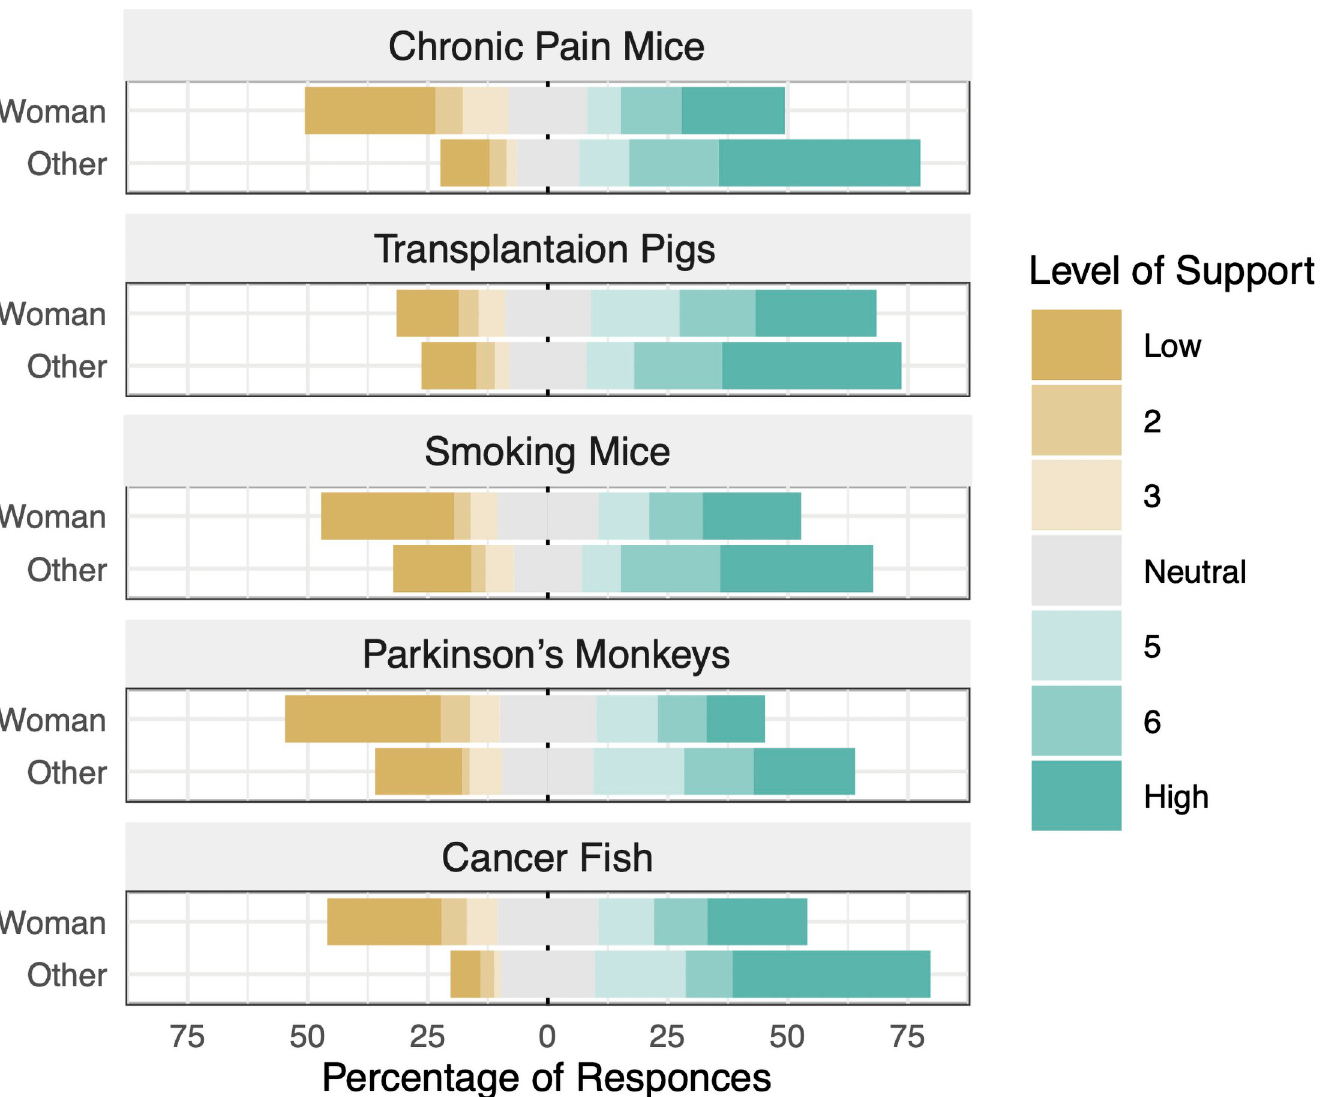
Fig 1. Distribution of participant ( n = 1521) support (1 = “No” to 7 = “Yes”) for research proposals describing chronic pain research with mice, organ transplant research with pigs, smoking research with mice, Parkinson’s disease research with monkeys, and cancer research with zebrafish. Results are shown separately for participants who identified as female versus those with any other gender